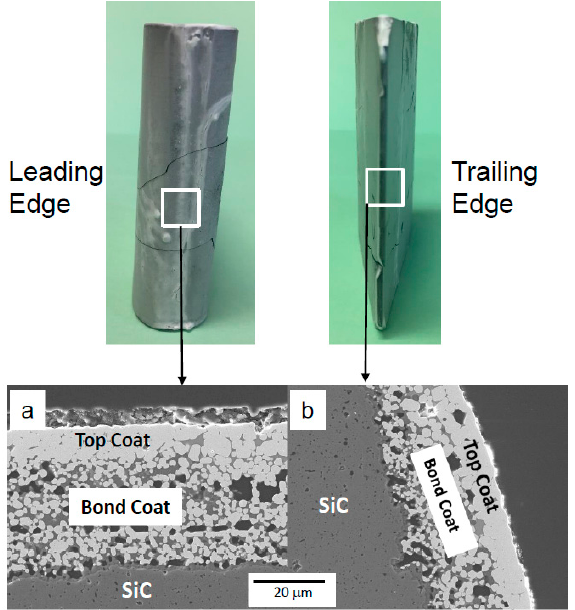
Figure 8. Cross-sections of EBC-coated sintered SiC airfoil after 100 cycles at 1480 °C in air with 1 h hot and 20 min cooling to room temperature per cycle: ( a ) leading edge; ( b ) trailing edge.